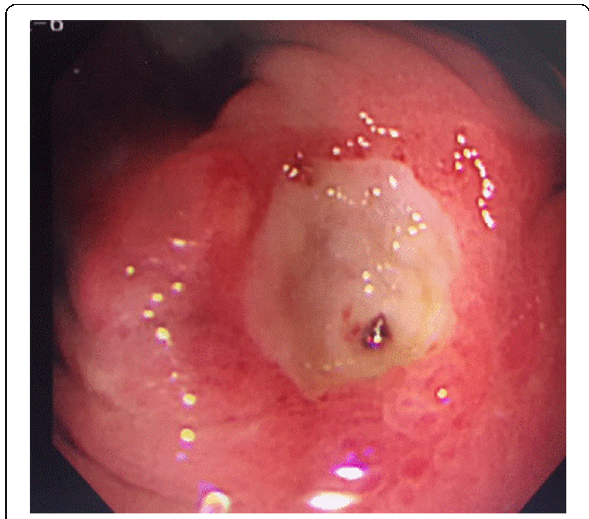
Fig. 2 Any area of the mucosa which turned black-blue (pH < 3.0) within the first 3